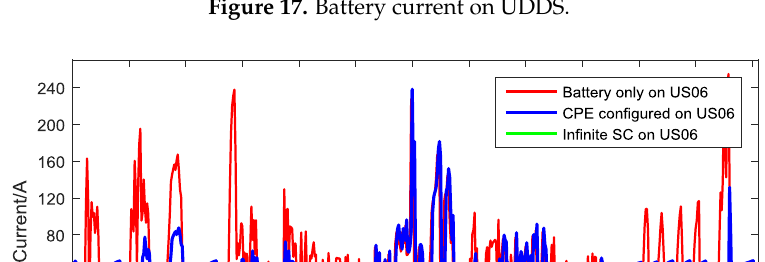
Figure 17. Battery current on UDDS.